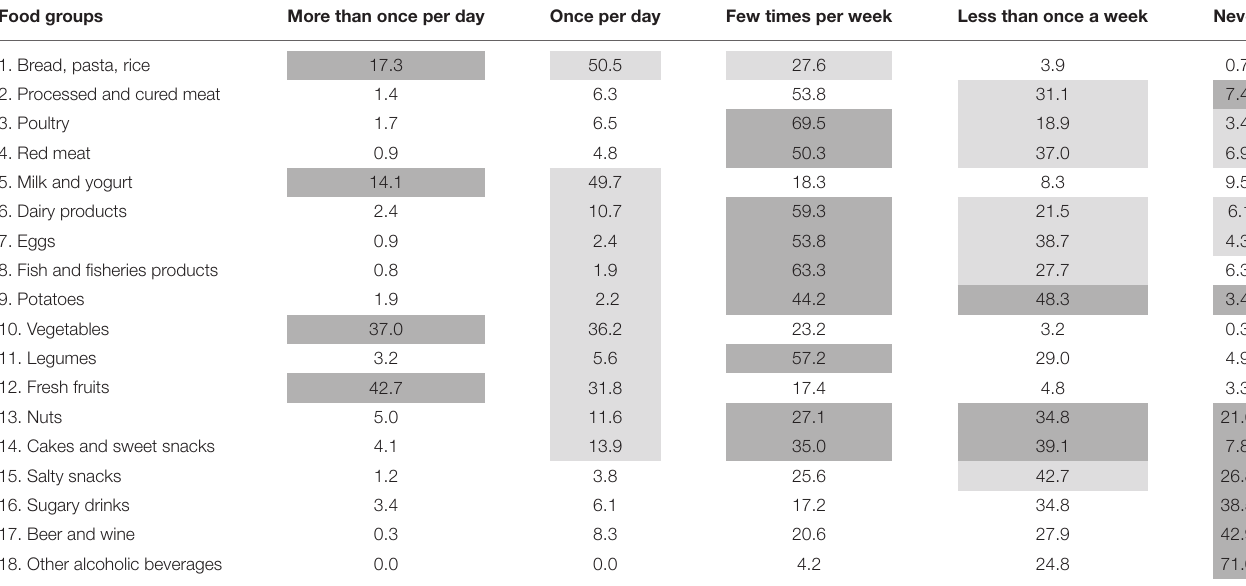
TABLE 5 | The frequency of consumption of food groups. Food groups More than once per day Once per day Few times per week Less than once a week Never